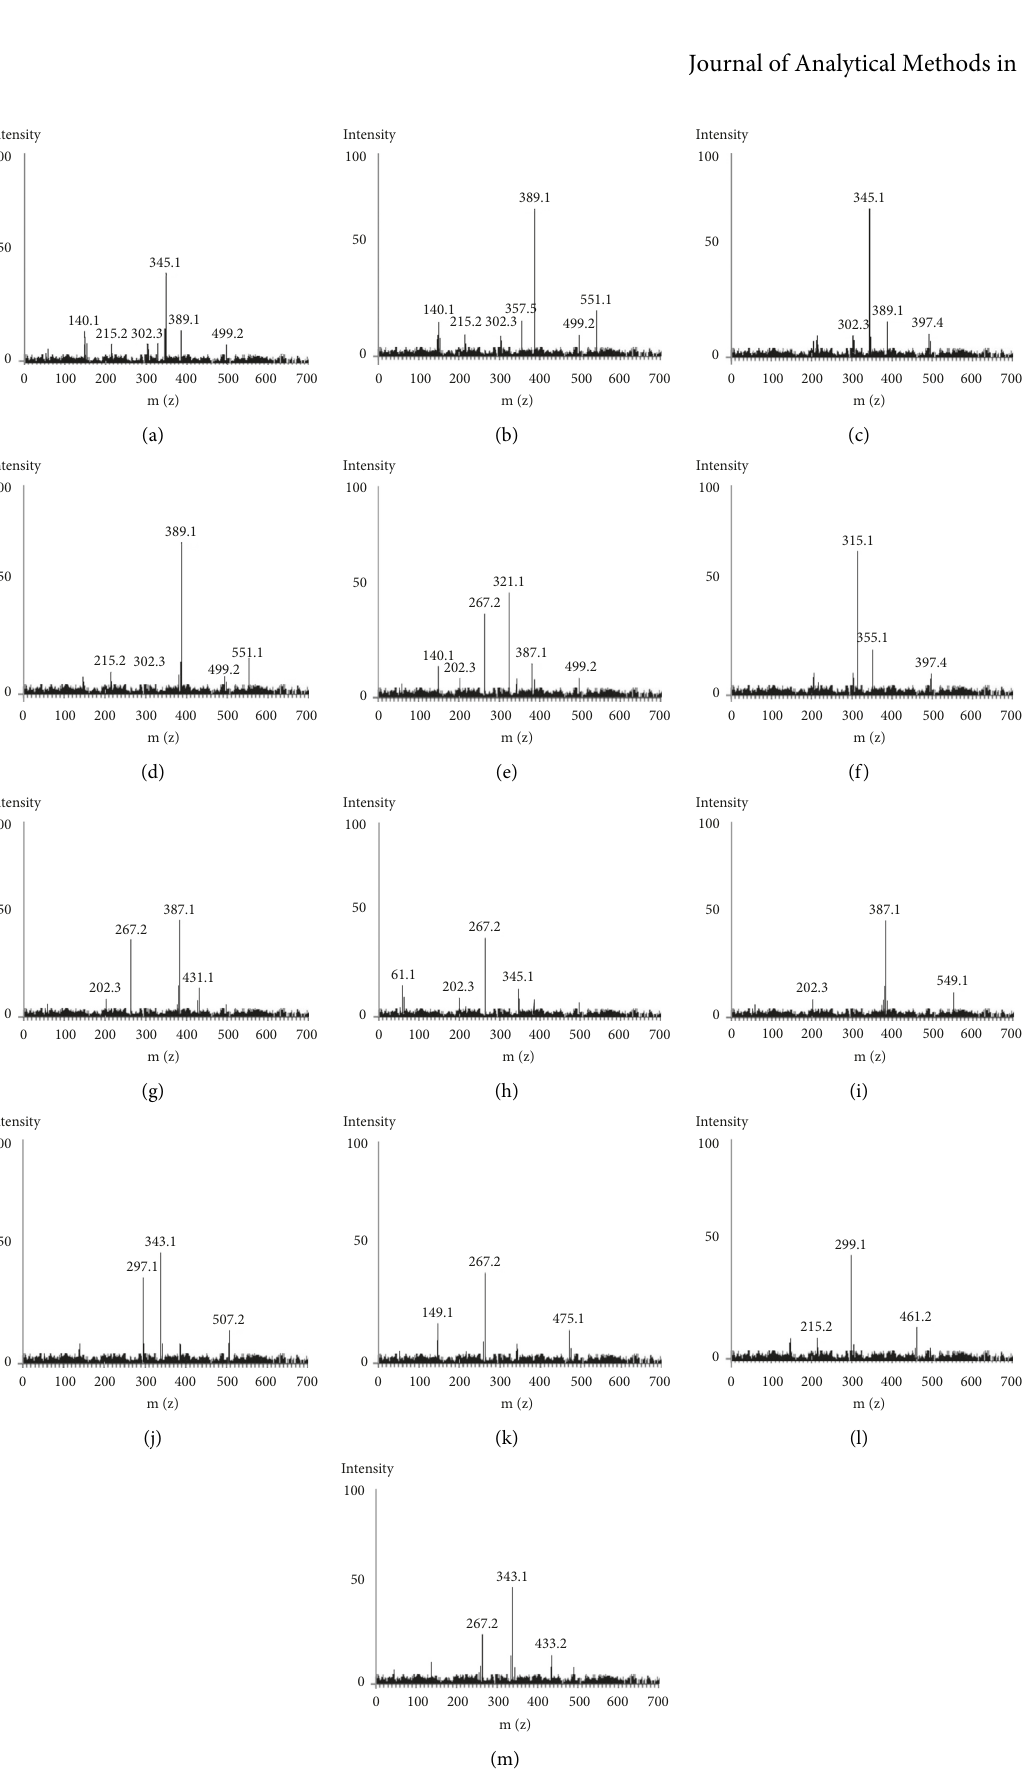
Figure 5: MS-MS spectra of the betalains compounds identified in Beta vulgaris L peels and pomaces extract; (a) 2-O-glucosyl-betanin; (b) betanin; (c) 2-O-glucosyl-isobetanin; (d) isobetanin (isobetanidin 5-glucoside); (e) betanidin; (f) ferulic acid hexoside; (g) 17-decarboxy- neobetanin; (h) isobetanidin (17 –decarboxy-betanidin); (i) neobetanin; (j) 17-decarboxy-betanin; (k) 2, 17-bidecarboxy-betanin (iso- betanin); (l) 2,17-bidecarboxy–neobetanin, and (m) isovitexin (apigenin 6-C-